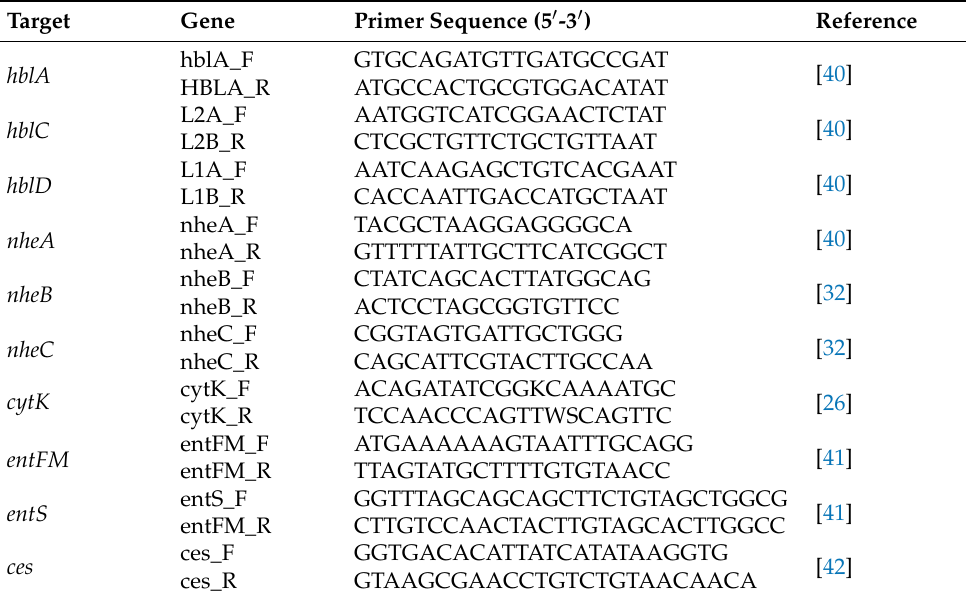
Table 1. PCR primers targeting the virulence genes investigated in this study.